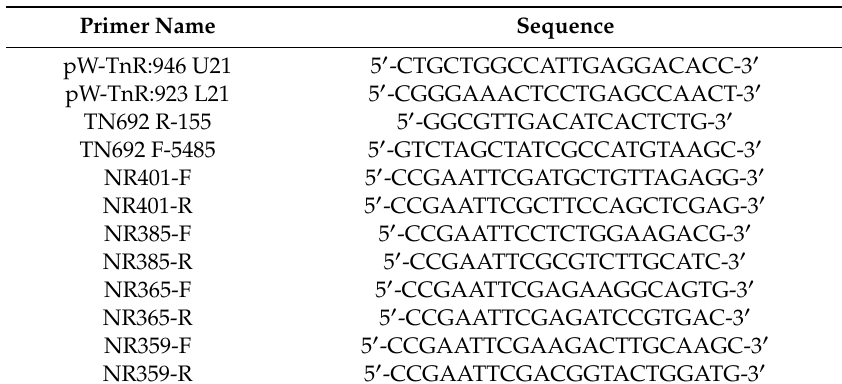
Table 2. DNA primers used for the amplification of nucleotide